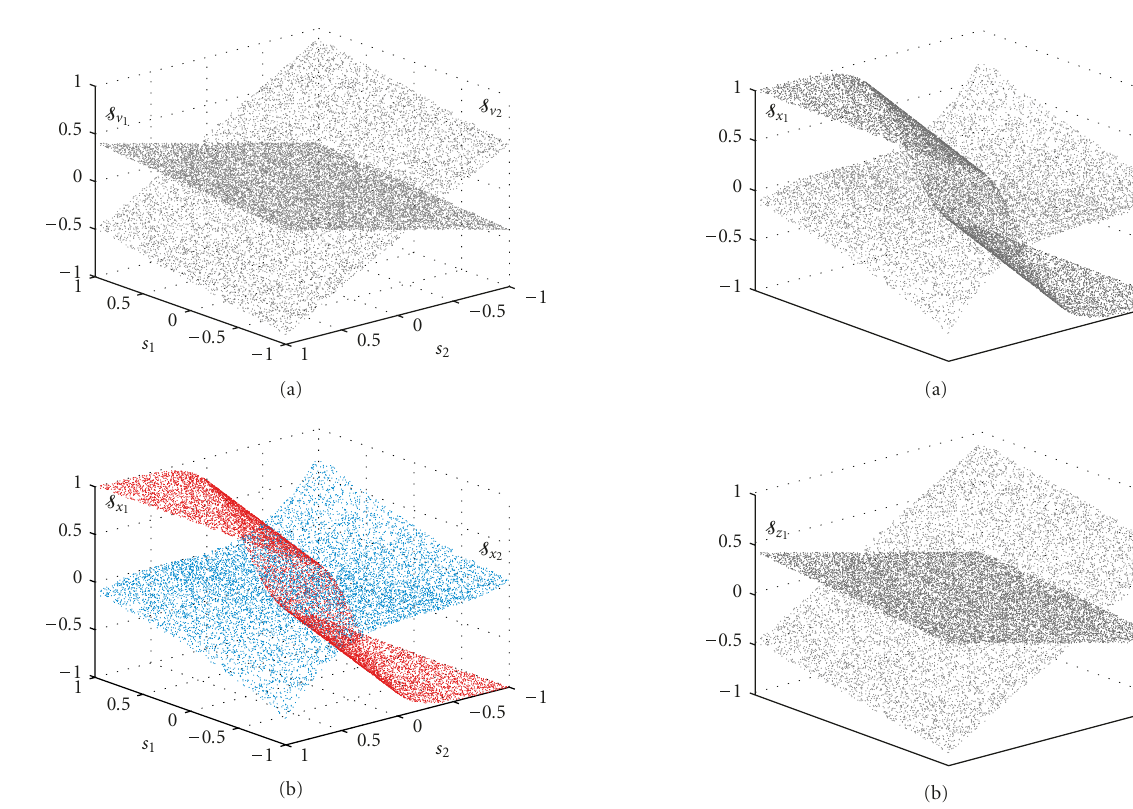
Figure 4: Example of the PNL separating system in 3D space. (a) and S x correspond to the observations. (b) Nonlinear surface S x 1 2 and S z correspond to linearized mixtures z 1 and z 2 Planes S z 1 2